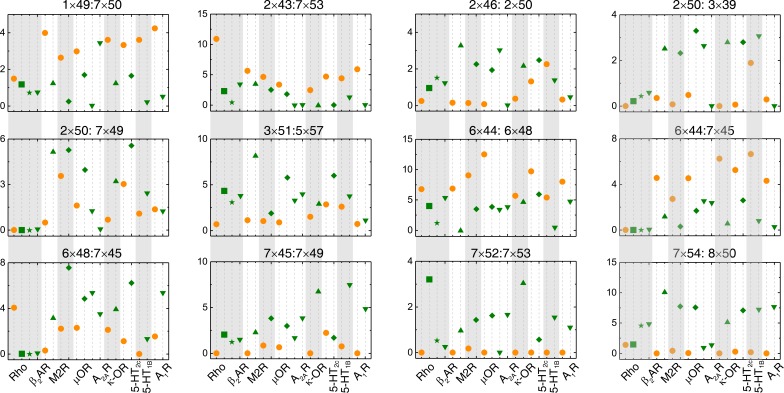
The repacking conformation change is conserved upon receptor activation.Comparison of RRCS for active (green) and inactive (orange) states of eight receptors with different intracellular binding partners, including four recently solved cryo-EM structures of Gi/o-bound receptors (5-HT1B receptor, rhodopsin, A1R and µOR) whose resolutions were low (usually ≥3.8 Å for the GPCR part). Nevertheless, almost all conserved residue rearrangements in the pathway can be observed from them. Twelve of 34 residues pairs were shown here, see Figure 4 and Figure 4—figure supplement 1 for the remaining residue pairs.